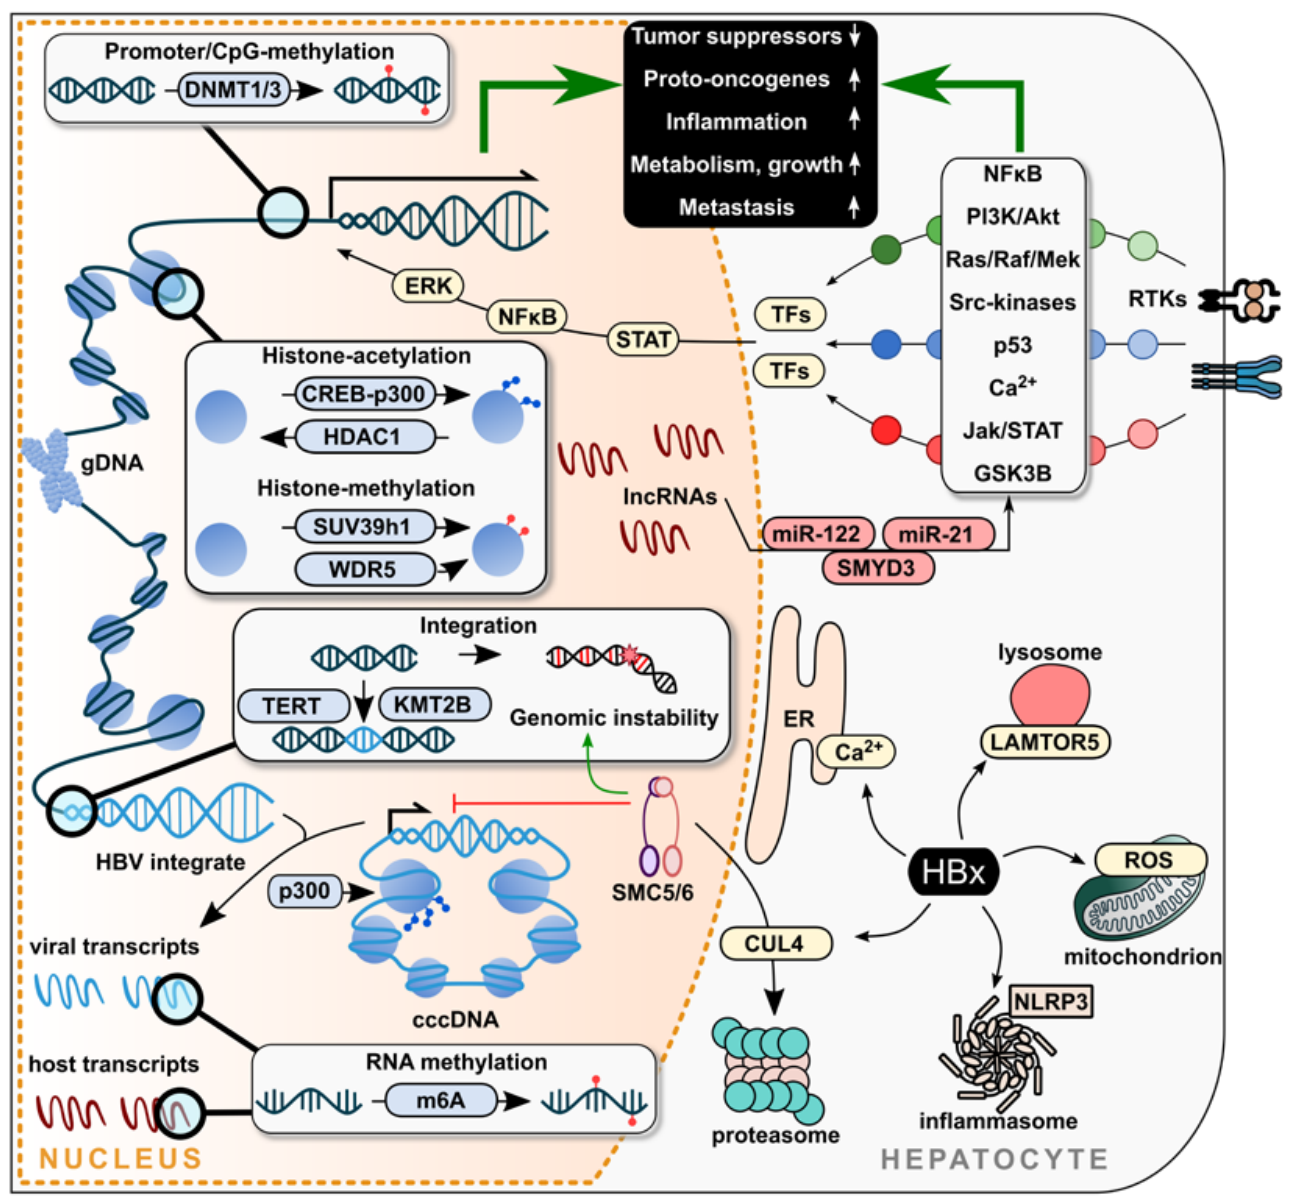
Figure 1. Schematic overview of HBx-mediated signaling pathways in the context of hepatocellular carcinoma progression. The multifunctional protein HBx deregulates several cellular pathways in the cytosol and nucleus, which are key factors participating in the development of HBV-induced liver pathogenesis and tumorigenesis. Nuclear pathways include the epigenetic modification by DNA methylation via DNMT1/3 as well as histone modifications via CREB-p300, HDAC1, WDR5 or SUV39h1. On the other hand, host and viral RNA methylation via m6A is also regulated by HBx. Additionally, HBx drives the expression of non-coding RNA (lncRNA and miRNA) such as miR-122, miR-21 or SMYD3. The integration of viral DNA into the host genome in proximity of the genes TERT, KMT2B or others enhances the pool of HBx transcripts and leads to genomic instability within the host genome. Cytosolic HBx mediates dysregulation of signaling pathways in hepatocytes, which is mediated by interaction with several cellular proteins of the ER, affecting cellular Ca 2+ homeostasis at the lysosome (LAMTOR5) and mitochondria, thereby inducing ROS, the NLRP3 inflammasome and proteasomal adaptors such as CUL4. Thereby, it elicits expression of genes being regulated by, e.g., ERK, NF- κ B, STAT or other TFs. Further, the interaction of HBx with SMC5/6 facilitates viral replication and plays a key role in DNA damage repair mechanisms. Ca 2+ , calcium ions; cccDNA, covalently closed circular DNA; CpG, cytosine-phosphate-guanosine; CREB, cAMP response element-binding protein; CUL4, cullin 4; DNMT1/3, DNA methyltransferases; ER, endo- plasmic reticulum; ERK, extracellular signal-regulated kinase; gDNA, genomic DNA; GSK3B, gly- cogen synthase kinase-3 beta; HBV, hepatitis B virus; HDAC1, histone deacetylase 1; JAK, Janus kinase; KMT2B, lysine methyltransferase 2B; LAMTOR5, late endosomal/lysosomal adaptor, MAPK and mTOR activator 5; m6A, N6-methyladenosine methyltransferase; MAPK and MTOR activator 5; lncRNA, long non-coding RNAs; miRNA, micro RNA; NF- κB, nuclear factor kappa B; NLRP3, NLR family pyrin domain containing 3; p300, histone acetyltransferase p300; p53, tumor protein p53; PI3K, phosphoinositide-3-kinase; AKT, protein kinase B; Ras, rat sarcoma protein; Raf, rapidly accelerated fibrosarcoma protein; Mek, mitogen-activated protein kinase; ROS, reactive oxygen spe- cies; RTKs, receptor tyrosine-kinases; SMC5/6, structural maintenance of chromosomes 5/6; SMYD3, SET and MYND domain containing 3; Src, SRC proto-oncogene; STAT, signal transducer and